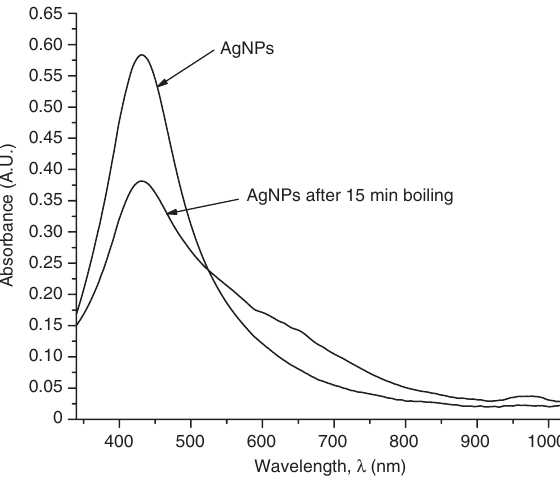
Figure 8 Absorption spectra of AgNPs before (1) and after (2) heating (15 min incubation at T = 373 K) [AgNPs] – 0.72 × 10 –4 mol/l (Ag 0 ), [NaNO ] – 10 -2 3